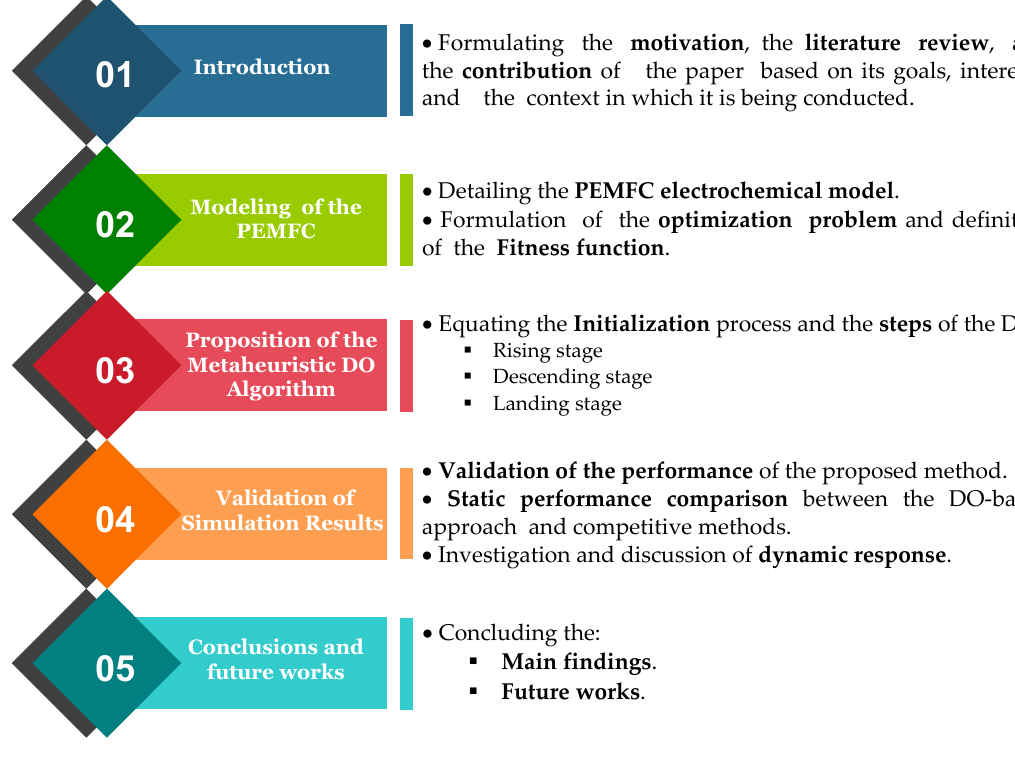
Figure 1. Flowchart illustrating the Research methodology .